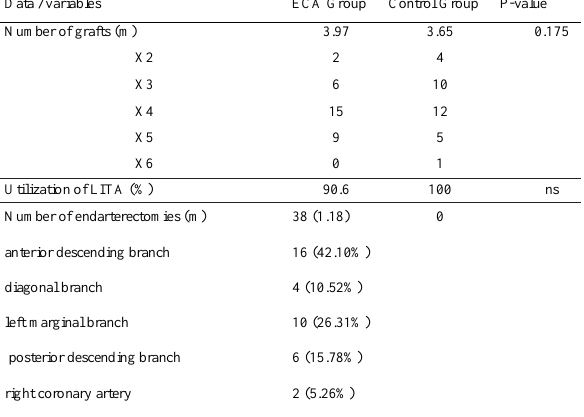
m = mean by patient; ATIE = left internal thoracic artery.